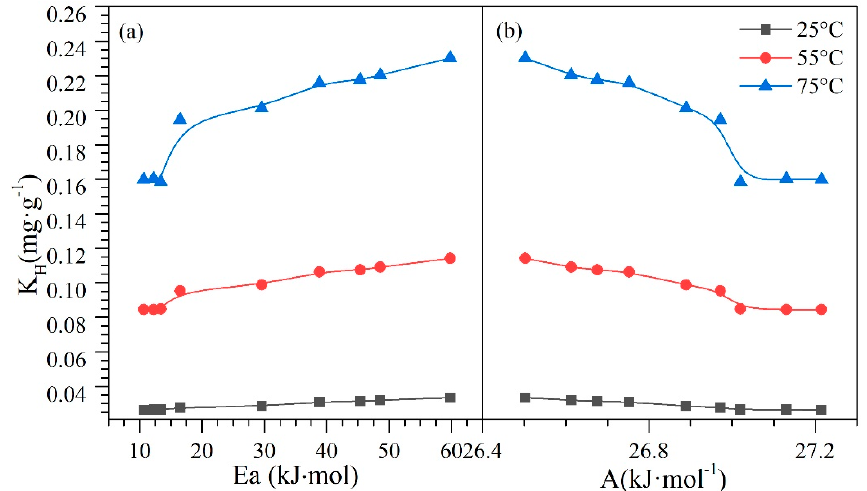
Figure 12. The relationship between Henry’s law constant and ( a ) Polanyi’s adsorption potential and ( b ) effective activation energy for n -C 7 asphaltene adsorption onto CeNi0.89Pd1.1 nanoparticles and subsequent catalytic steam decomposition through regeneration catalytic cycles.